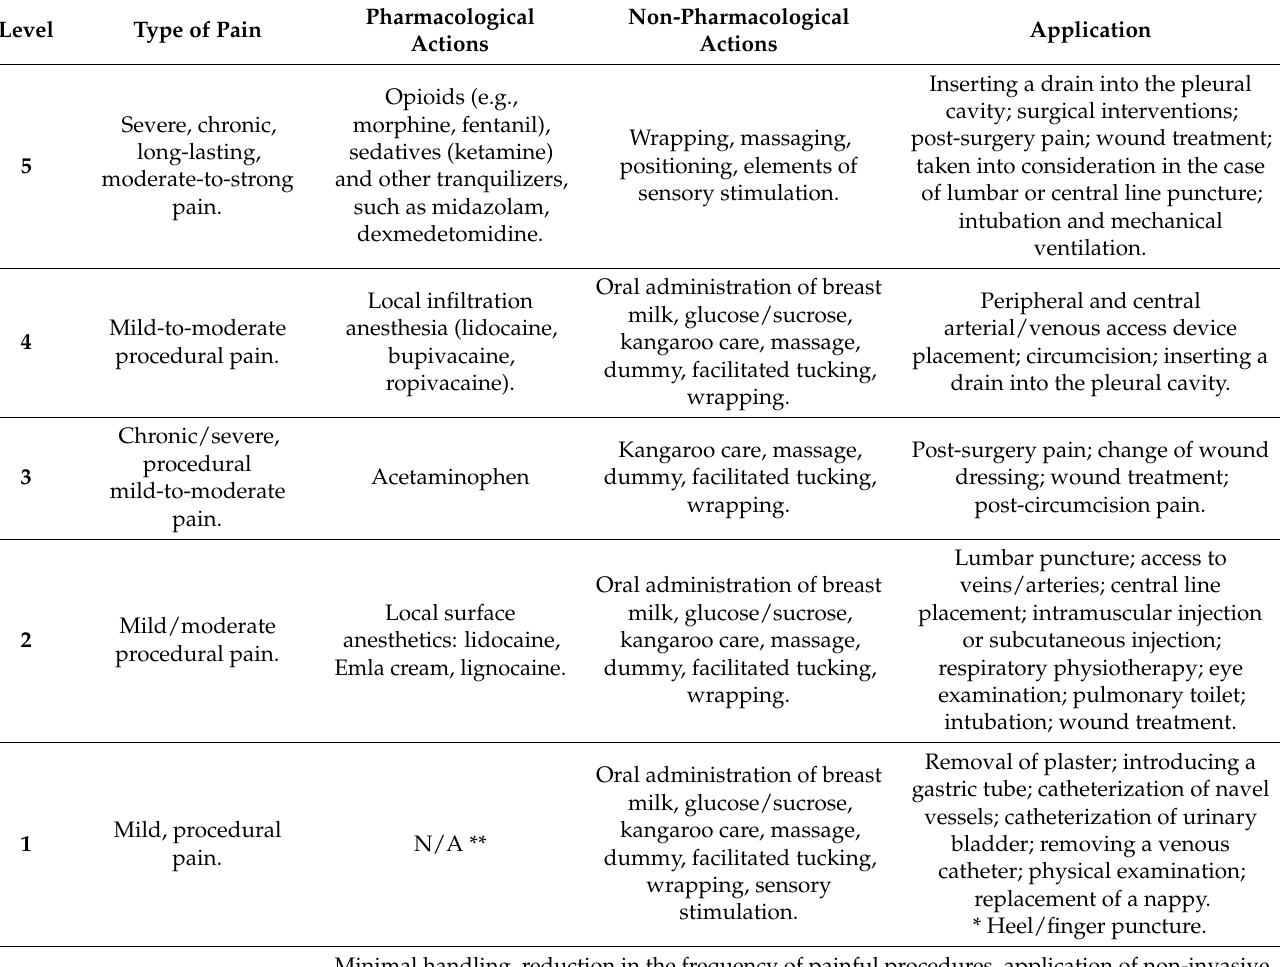
Table 1. Six-level pain-management therapy